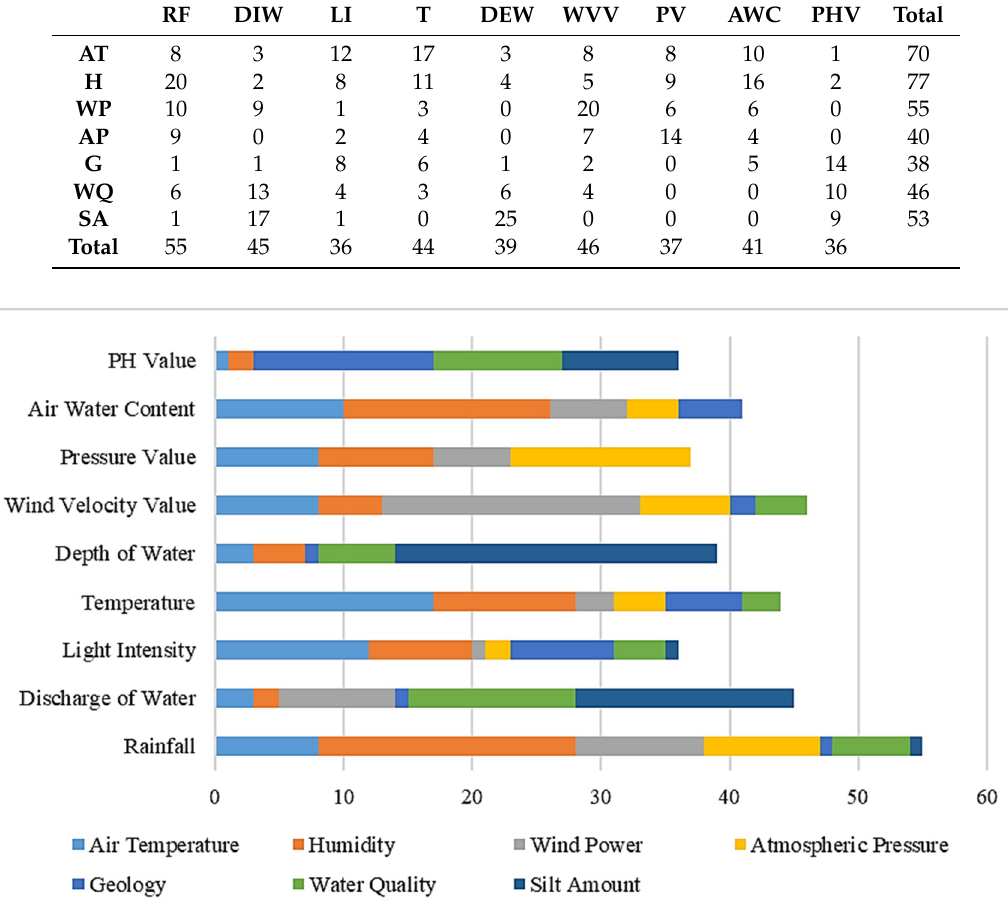
Table 5. Similarity results based on instance strategy.